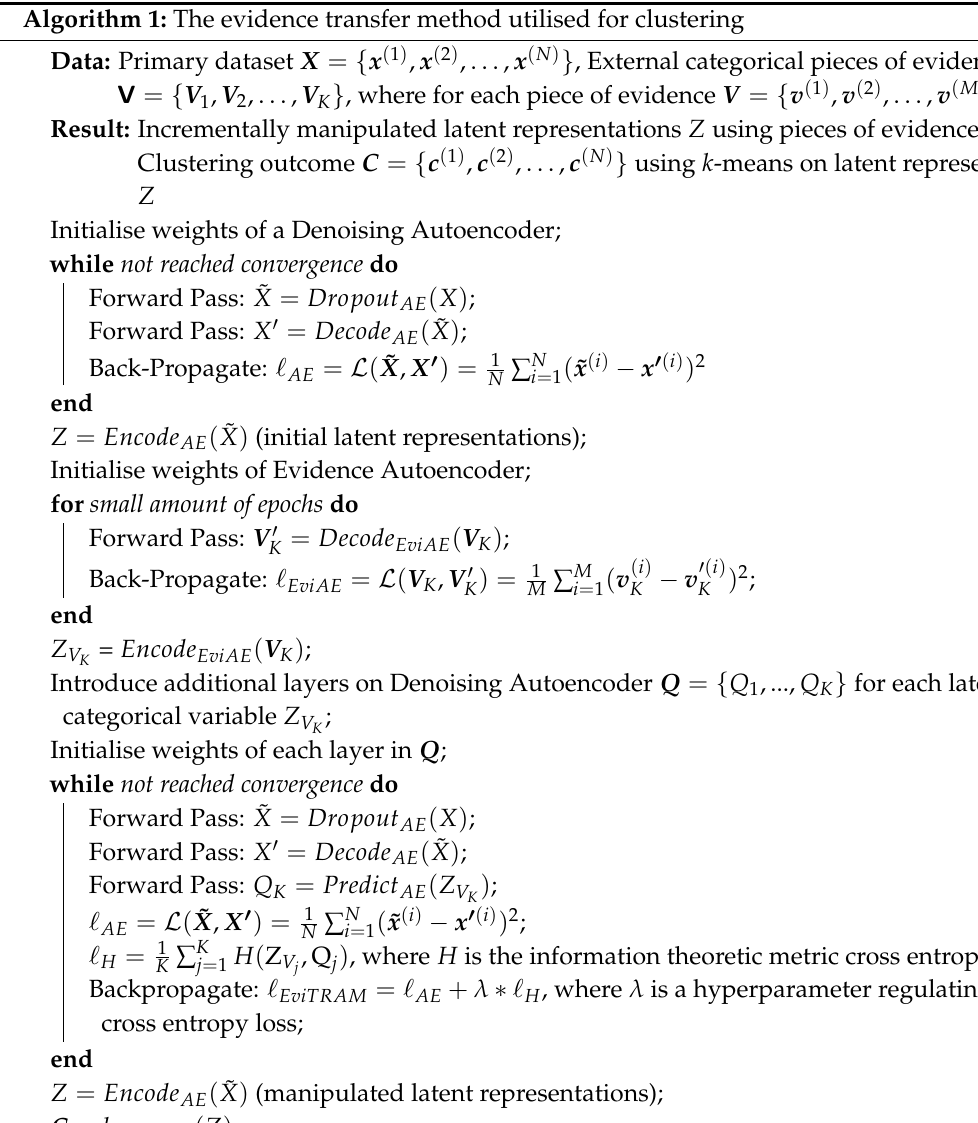
Algorithm 1: The evidence transfer method utilised for clustering Data: Primary dataset X = { x ( 1 ) , x ( 2 ) , . . . , x ( N ) } , External categorical pieces of